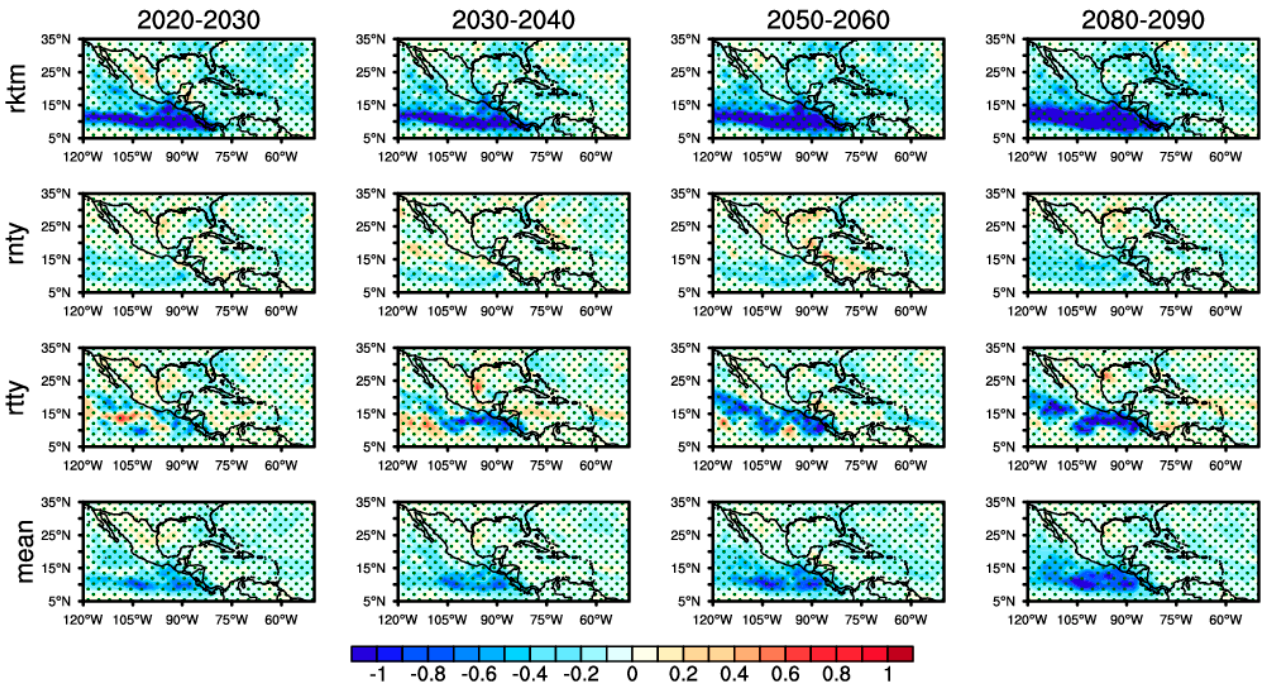
Figure 5. Annual mean anomalies of tropical cyclone density in the future ensemble runs over Tropical North America with respect to the reference period (1990–2000). The dotted regions indicate a 95% significance level applying the Kolmogorov–Smirnov two-sample test.